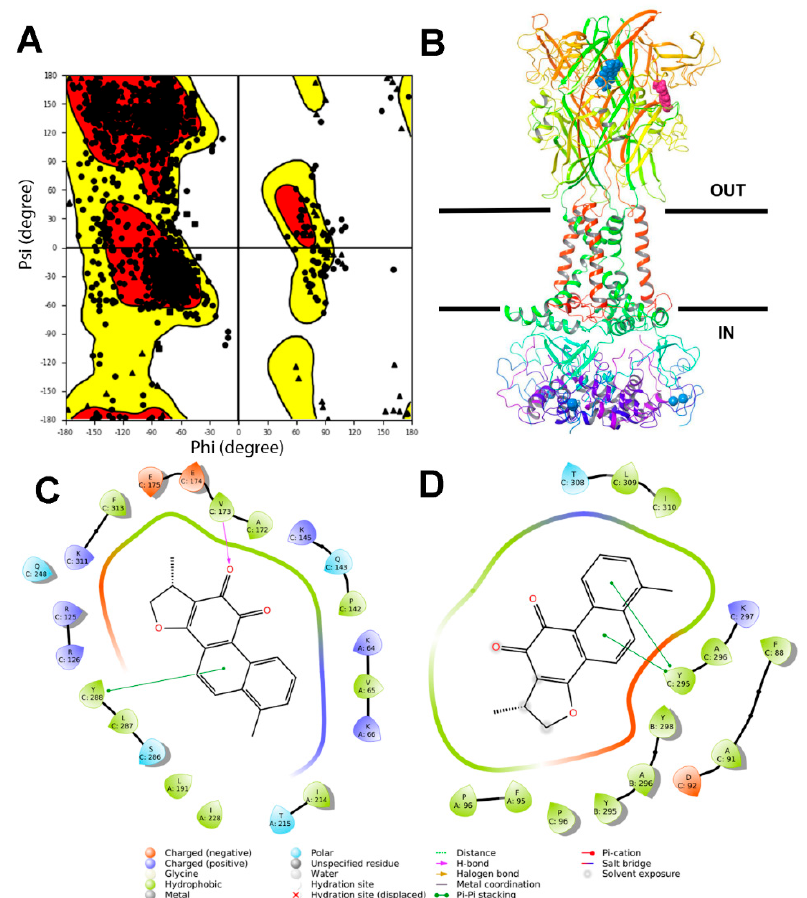
Figure 1. DHTS is predicted to bind the allosteric site of the human P2X7R. ( A ) Ramachandran plot of the full-length hP2X7R model, after energy minimization in an implicit solvent and membrane. ( B ) Representation of DHTS poses in the orthosteric (magenta Van der Waals spheres) and the allosteric (blue Van der Waals spheres) pockets of P2X7R. ( C ) The ligand interaction of a 2D diagram of DHTS in the orthosteric pocket of P2X7R. ( D ) The ligand interaction 2D diagram of DHTS in the allosteric pocket of